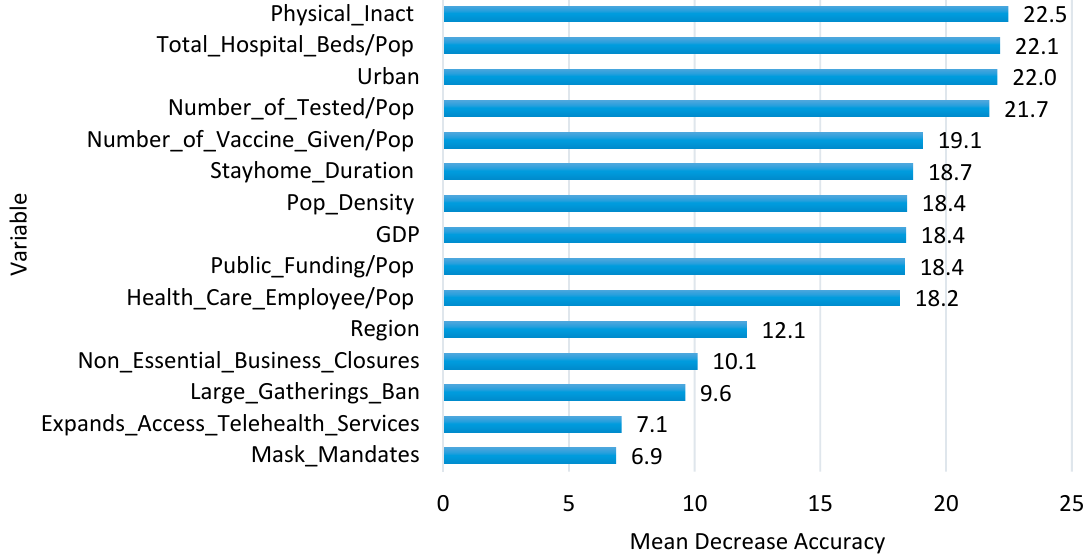
Figure 4. Importance Score of Predictor Variables from RF (Mean Decrease Accuracy).